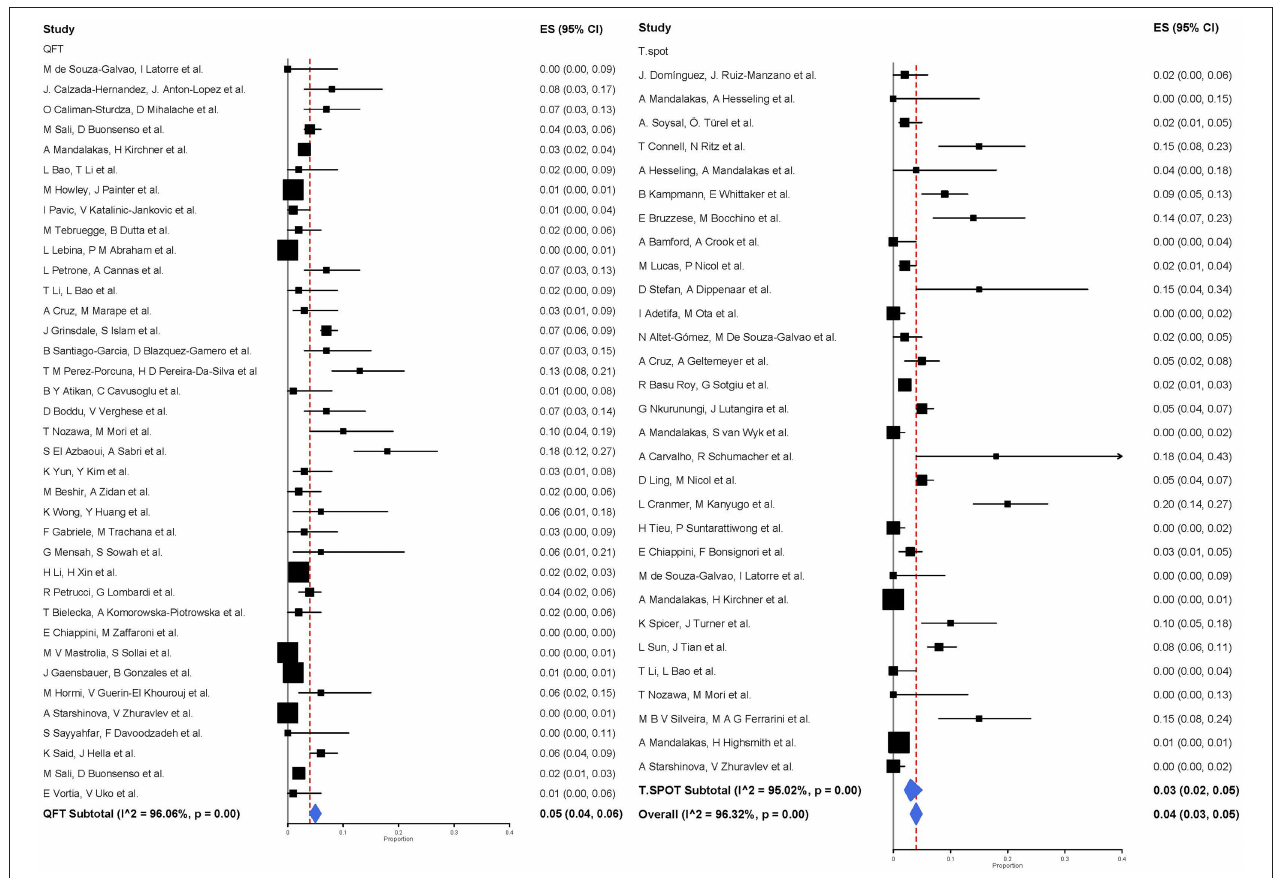
FIGURE 2 | Proportion of indeterminate results with 95% CI by type of IGRA. Studies arranged according to year of